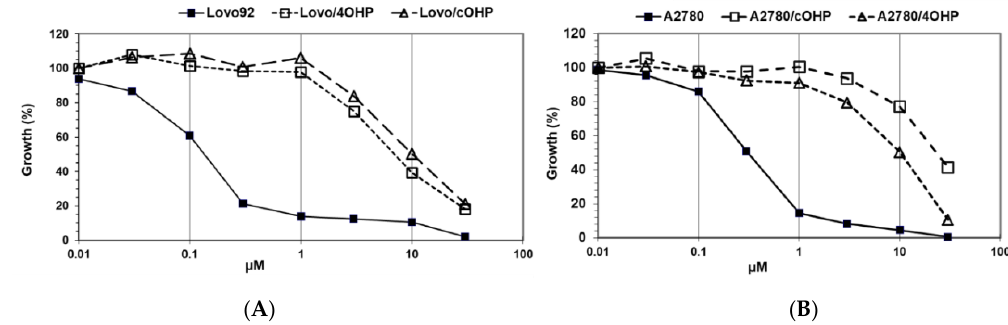
Figure 1. Sensitivity of Lovo-92 ( A ) and A2780 ( B ) parent cell lines and their oxaliplatin resistant variants 4OHP and cOHP. Curves are from a representative experiment performed in triplate out of at least three separate experiments. Table 1. Sensitivity to oxaliplatin and cisplatin in parental- and drug-resistant variants of colon and ovarian cancer cell lines .